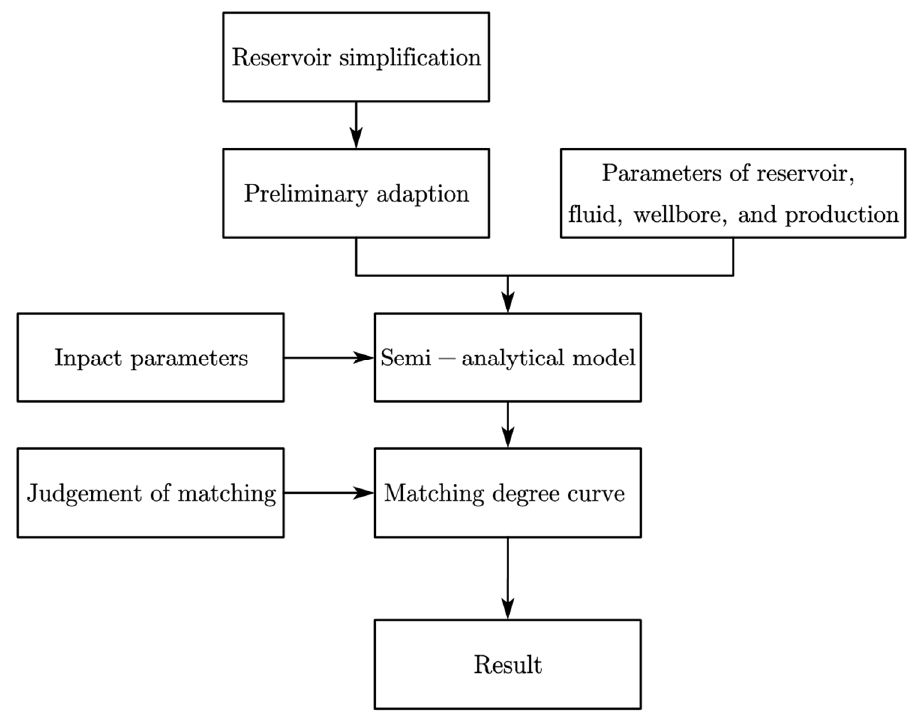
Figure 14. Flow chart of matching method between unconventional wells and reservoir.